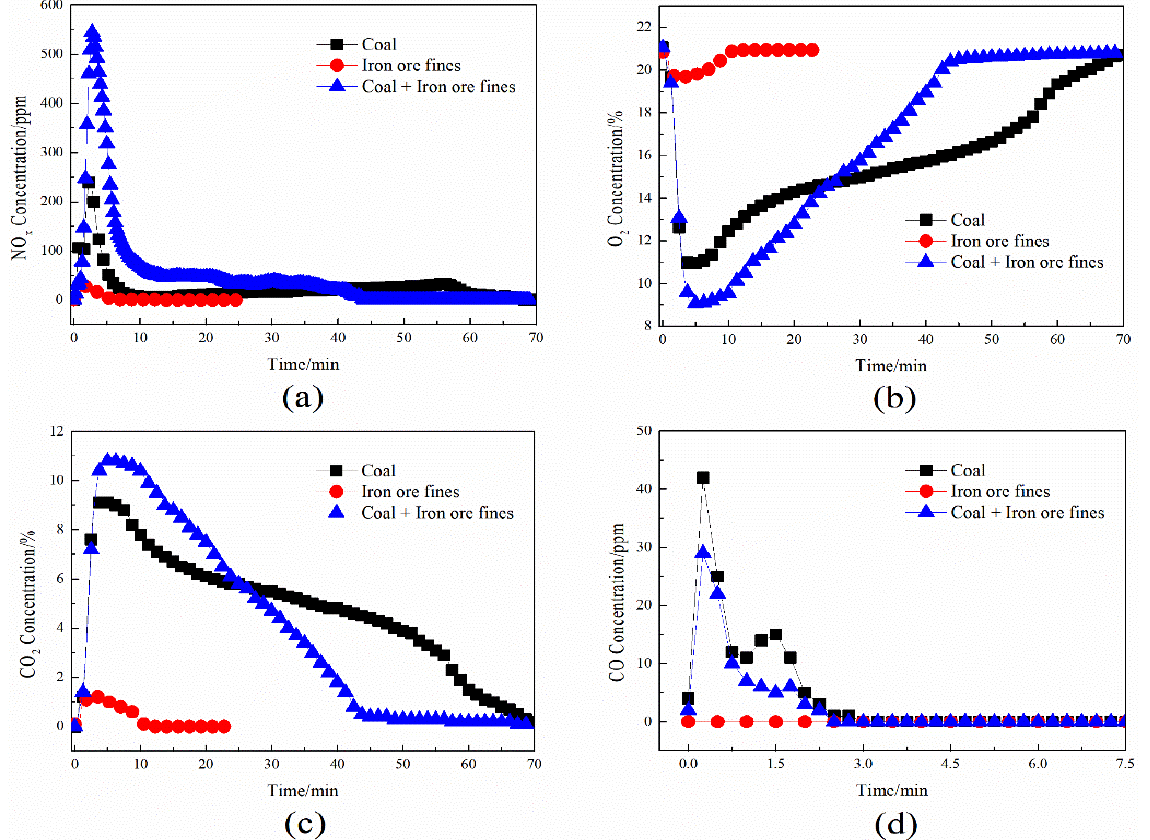
Figure 4. Effects of iron ore fines on flue gas composition characteristics in pulverized coal combustion: ( a ) NO x concentration, ( b ) O 2 concentration, ( c ) CO 2 concentration, ( d ) CO concentration. Table 3. Effects of iron ore fines on flue gas composition characteristics in pulverized coal combustion. Test